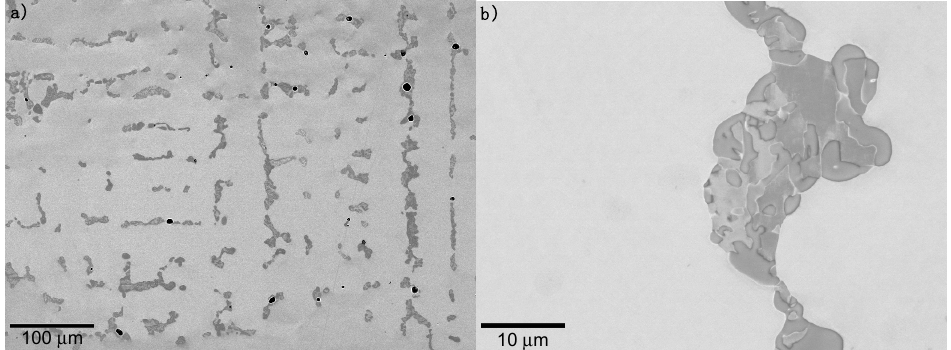
Figure 5. BSE micrographs of heat-treated Co-101, ( a ) low magnification image showing the dendritic microstructure of Co-101, ( b ), higher magnification image of the interdendritic M 7 C 3 phase.